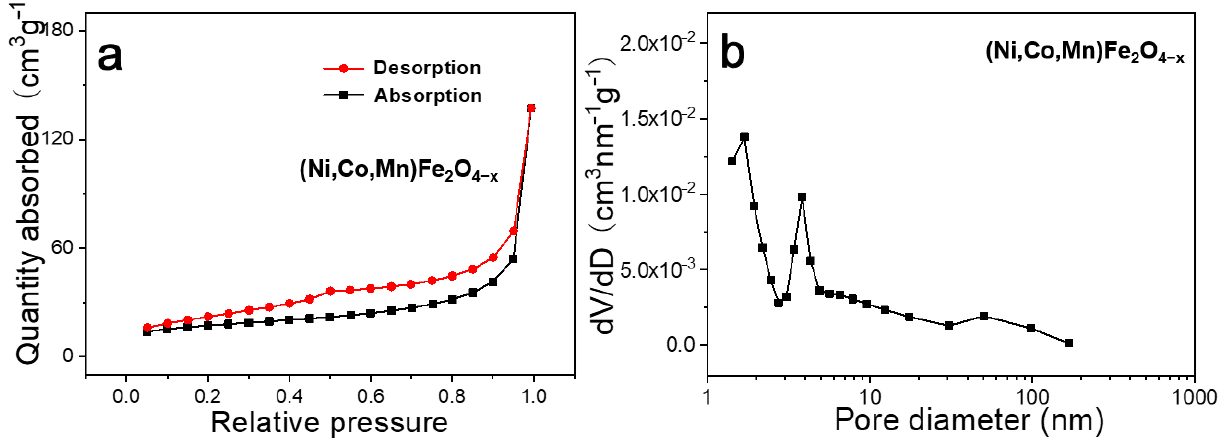
Figure 4. N 2 adsorption–desorption isotherm of (Ni,Co,Mn)Fe 2 O 4 − x ( a ) and corresponding pore-size distribution ( b ).